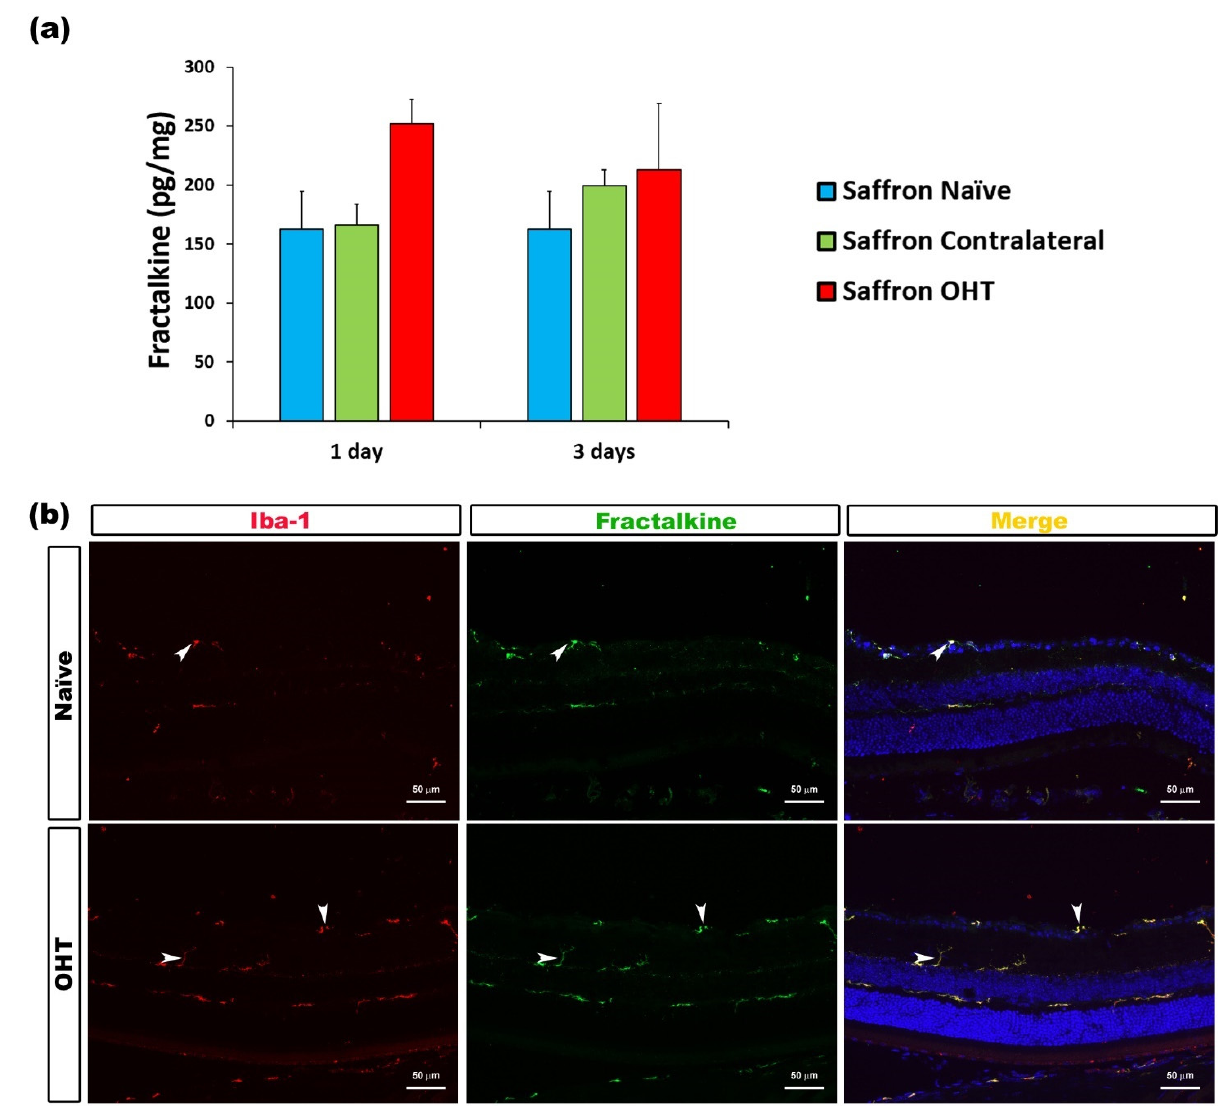
Figure 11. Fractalkine levels at 1 and 3 days after laser-induced ocular hypertension (OHT). ( a ) The fractalkine values obtained in the multiplex assay. The histogram shows the mean levels (±SD) of fractalkine (pg/mg) at days 1 and 3 after laser OHT induction in saffron ocular hypertension eyes (saffron OHT) and saffron-contralateral eyes (saffron-contralateral) as well as in saffron-naïve eyes. ( b ) Immunohistochemical study of fractalkine expression in saffron OHT eyes one day after unilateral laser-induced OHT. Retinal sections were immunolabeled with antibodies to fractalkine (green) and Iba-1 (red). Merge is denoted by the colour yellow. The arrowhead shows the co-expression of Iba-1 and fractalkine in saffron OHT and saffron-naïve eyes. Abbreviations: OHT (ocular hypertension); Iba-1 (ionized calcium-binding adaptor molecule).